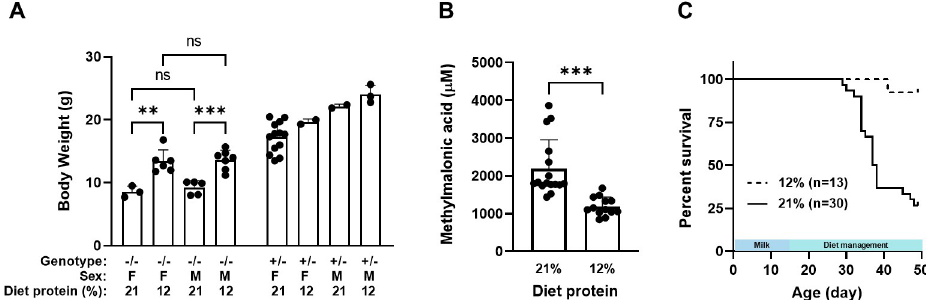
Fig 1. Body weight, circulating methylmalonic acid and animal survival in MMA mice on diets with standard (21%) and low (12%) protein content. Nursing dams were initially on a 21% protein diet. On PND 14, litters were either maintained on the 21% protein diet or switched to a 12% protein diet. (A) Body weight of MMA mice (-/-) and their heterozygous littermates (+/-) on PND 35. All heterozygous groups were significantly heavier than the gender- and diet-matched MMA groups. (B) Circulating methylmalonic acid level in MMA mice at PND 30. (C) Kaplan-Meier survival curves of MMA mice demonstrated significantly better survival of the 12% diet group than the 21% diet group. ��� P < 0.001, ���� P < 0.0001, Student’s t -test in (A) and (B). P < 0.0001, log-rank test in (C).